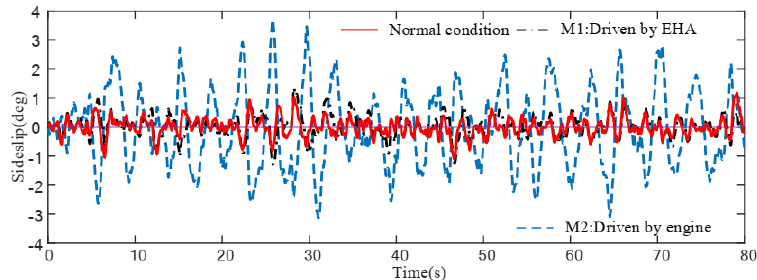
Figure 13. Sideslip angle response for damage scenario I under uncertainties and turbulences.